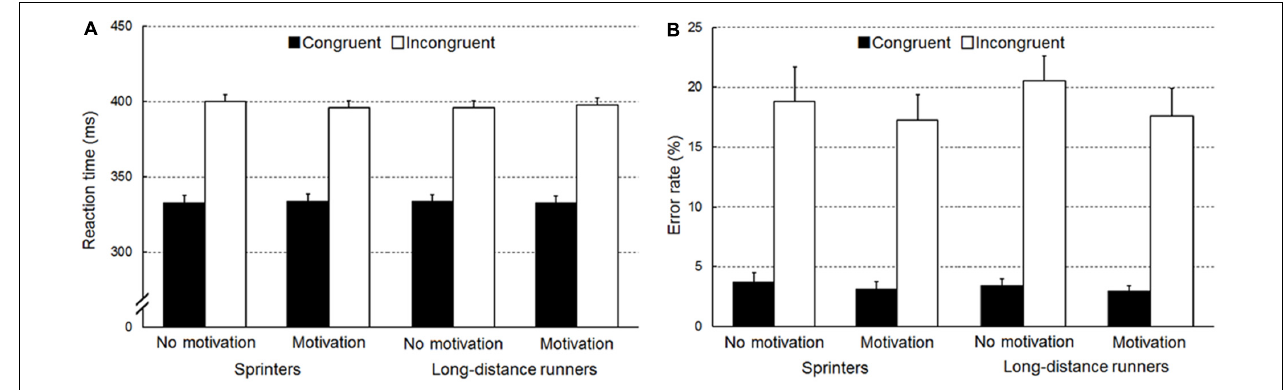
FIGURE 1 | (A) Reaction time [ms, standard error of the mean (SEM)] and (B) the error rate (%, SEM) are presented separately for sprinters and long-distance runners.